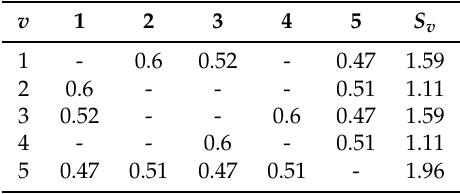
Figure 3. Example of the calculation of trust-value. Table 3. The similarities of nodes. The short dash indicates that there is no edge between the two